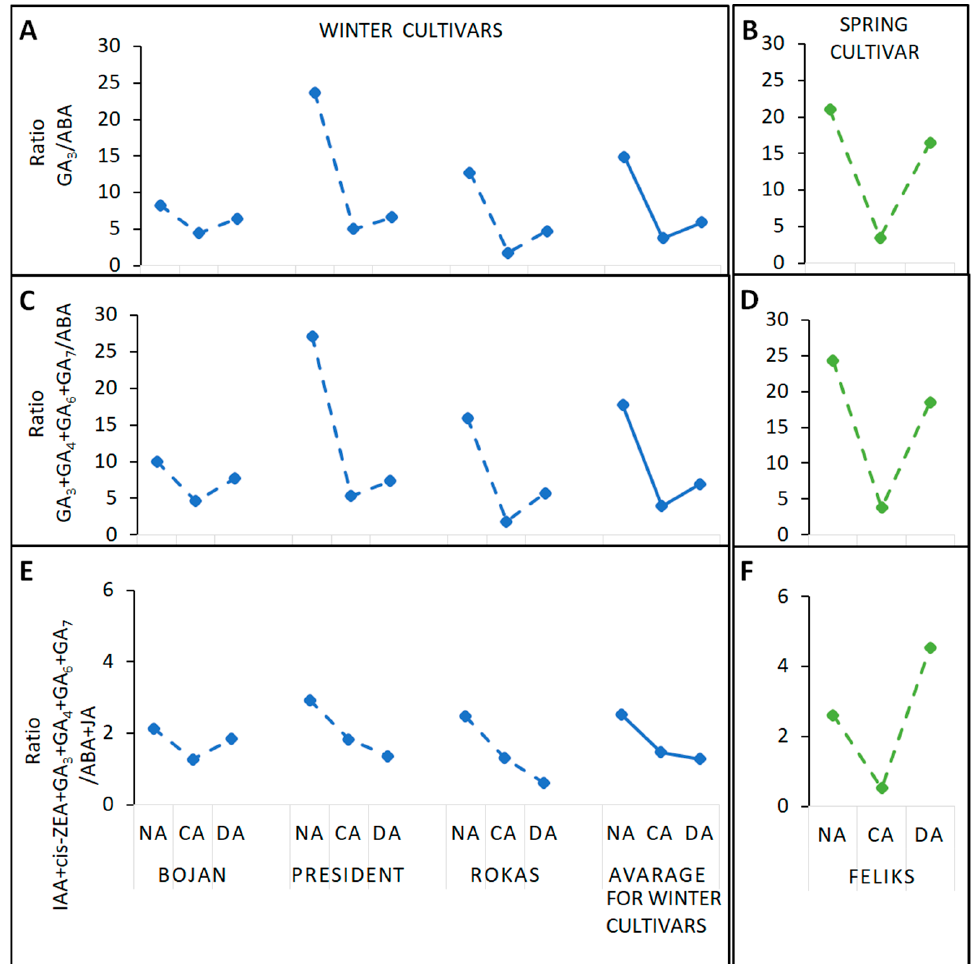
Figure 8. Visualization of the changes in the hormonal balance between the active forms of the growth promoting and stress hormones in the non-acclimated (NA), cold-acclimated (CA) and deacclimated (DA) plants of winter and spring cultivars of oilseed rape. Model is based on calculations of ratio GA 3 /ABA ( A , B ), ratio GA 3 + GA 4 + GA 6 + GA 7 /ABA ( C , D ) and ratio IAA + cis-ZEA + GA 3 + GA 4 + GA 6 + GA 7 /ABA + JA ( E , F ).